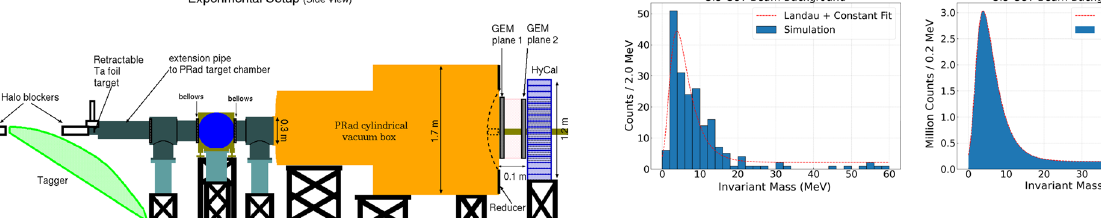
Fig. 50 (Left) The simulated background for 3.5 s of 100 nA beam at 3.3 GeV (corresponding to 2 . 2 × 10 12 electrons on target) and a fit to a sum of Landau + constant distribution. (right) The background counts are scaled to the beam time according to the fit, the number of events are sampled